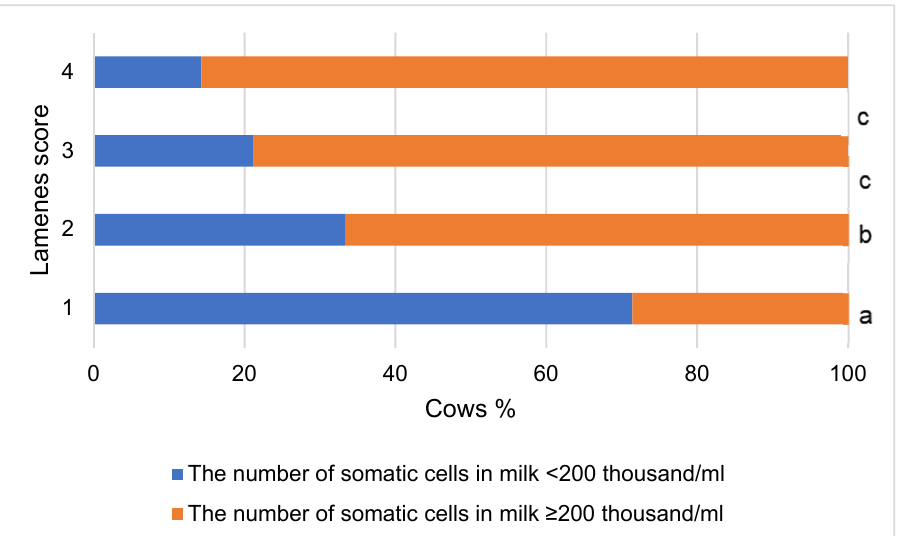
Figure 3. Relationship of lameness intensity with the level of somatic cells in milk. Lameness level—lameness score (1 = normal or non-lame cows, 2 = presence of a slightly asymmetric gait, 3 = the cow clearly favored one or more limbs (moderately lame), 4 = severely lame). a, b, c —different letters indicate that the difference in the frequencies of the somatic cell groups in terms of the lameness score is statistically significant ( p < 0.05).